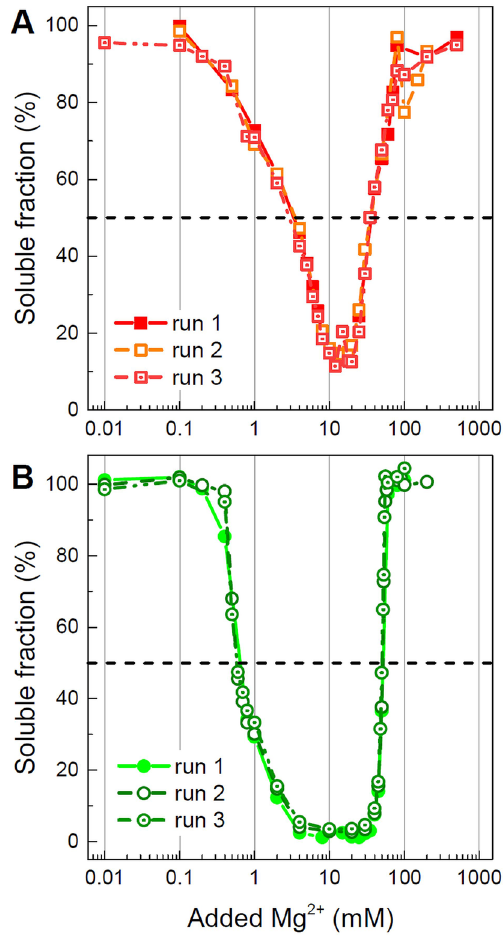
Figure 6. Mg 2+ -induced precipitation of the 177 bp nucleosome ( A ) and chromatosome ( B ) is reversible. The results of three independent measurements are shown for each chromatosome and nucleosome sample. In each graph, the dashed line shows 50% precipitation of the sample. OriginPro software 100 (www.origi nlab.com) was used to build the